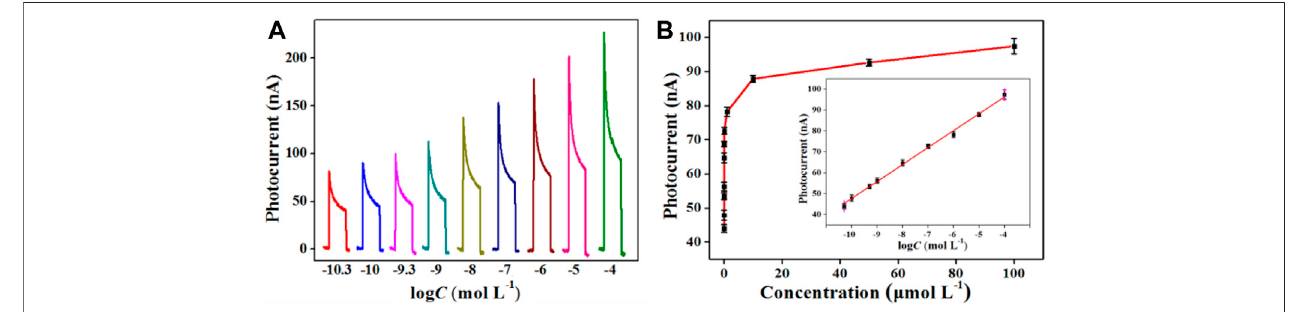
FIGURE 5 | Photocurrent responses of Bi 2 MoO 6 /ITO corresponding to L-Cys with varied concentrations (A) ; relationship between photocurrent changes and L-Cys concentrations (B) ; insert of part B, calibration curve between photocurrents and the logarithm of the L-Cys concentrations.